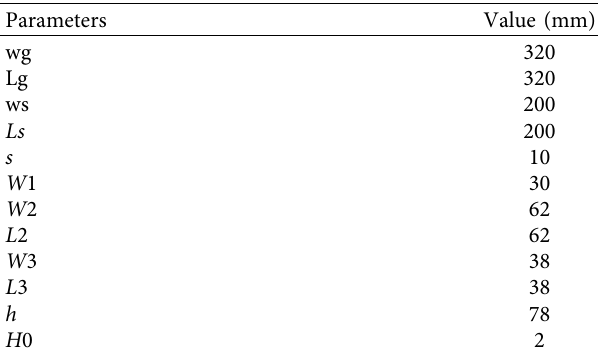
Figure 1: Configuration of the ultra-wideband dual-polarized antenna. Table 1: Dimensions of the proposed